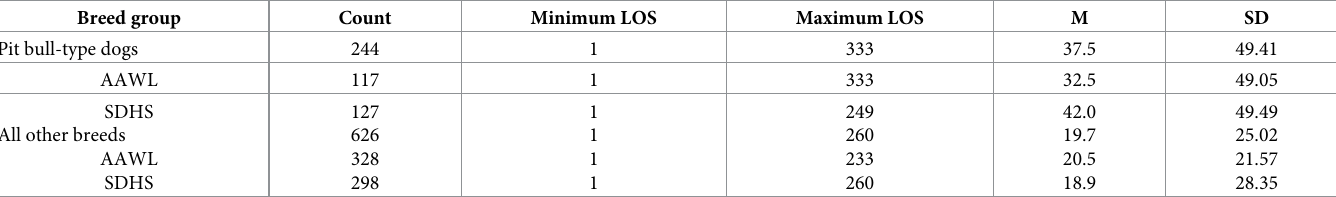
Table 5. Length of stay (LOS) in days for pit bull-type dogs and all other breeds at Arizona Animal Welfare League and San Diego Humane Society. Breed group Count